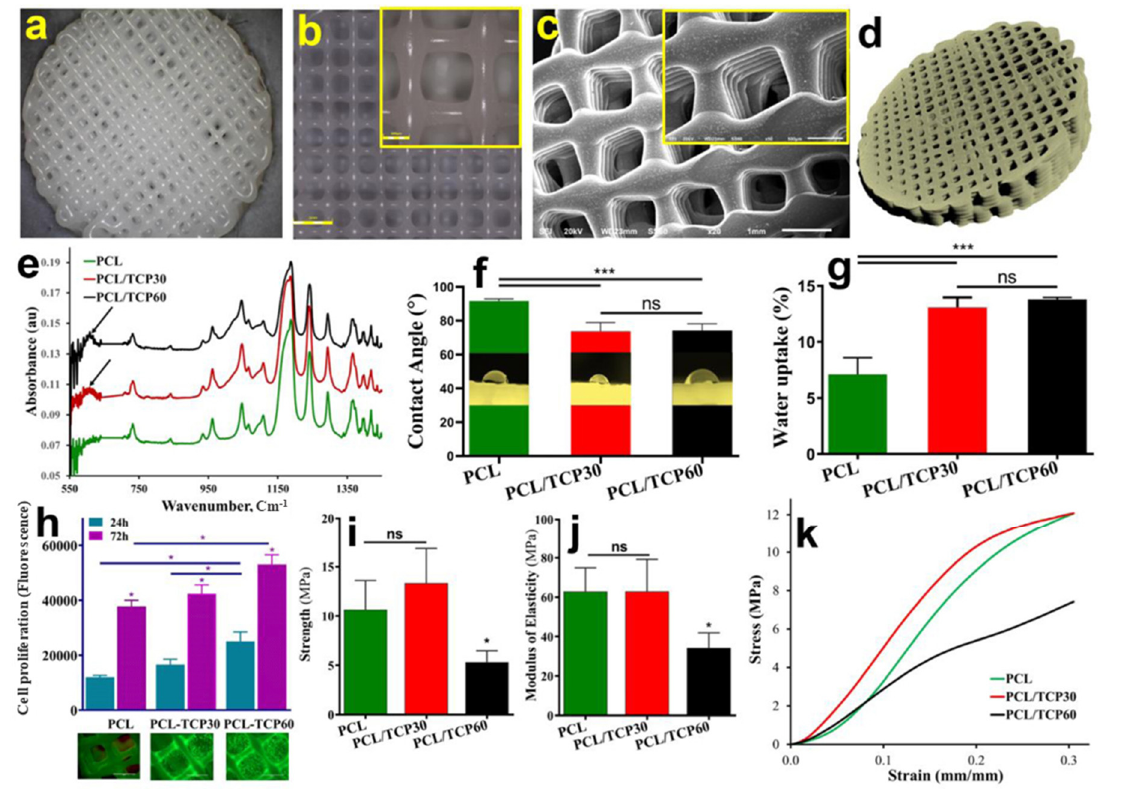
Figure 4. Characterization of 3D-printed functionally graded scaffolds. ( a ) Optical image of the 3D- printed scaffold; ( b ) 3D laser microscope images (scale bars: 2 mm and 500 µ m); ( c ) SEM images (scale bars: 1 mm and 500 µ m); ( d ) µ CT image; ( e ) FTIR spectra of polycaprolactone (PCL) and composite scaffolds; ( f ) water contact angle values of different scaffolds; ( g ) relative water absorption of various scaffolds; ( h ) cell viability and proliferation on scaffolds at different time points with Live/Dead staining data at the bottom (Scale bar: 1000 µ m); ( i ) compressive strength, ( j ) elastic moduli, and ( k ) stress–strain curve of scaffolds. PCL: beta-tricalcium phosphate (TCP): 1,6-hexanediamine (HAD), *: p < 0.05, ns: non-significance, ***: p < 0.001, s: significant. Reproduced with permission from [72]. Copyright 2021 Elsevier.